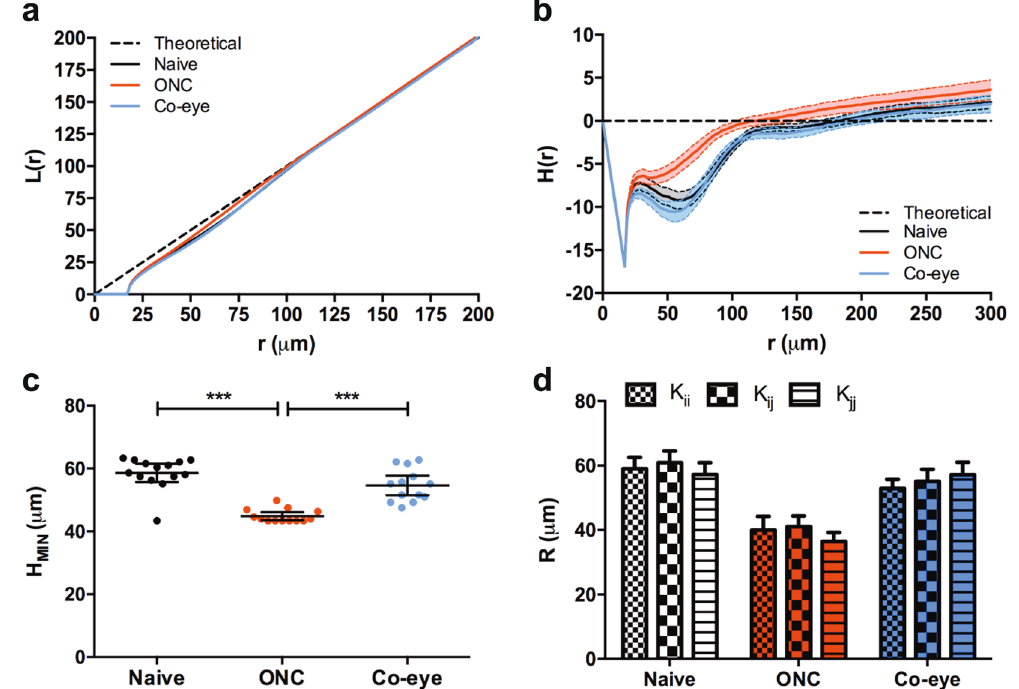
Figure 5. Ripley’s K -statistics, analysing spatial clustering of microglia subtypes. ( a ) For all treatment groups, L ( r ) and H ( r ) derivatives of Ripley’s K -function are negative for small values of r , indicating that retinal microglia have a dispersed topographical organisation. ( b ) Upon ONC, defined as the minimum of H ( r ), the domain radius of microglia decreases in size (one-way ANOVA with Tukey’s post hoc test). ( c ) Comparison of cross- K ( K ij ) and self- K functions ( K ii and K jj ) shows that ‘low activity’ and ‘high activity’ microglia subpopulations evenly decrease their domain radius after ONC injury (two-way ANOVA with Tukey’s post hoc test). Data are depicted as mean ± 95% confidence intervals.